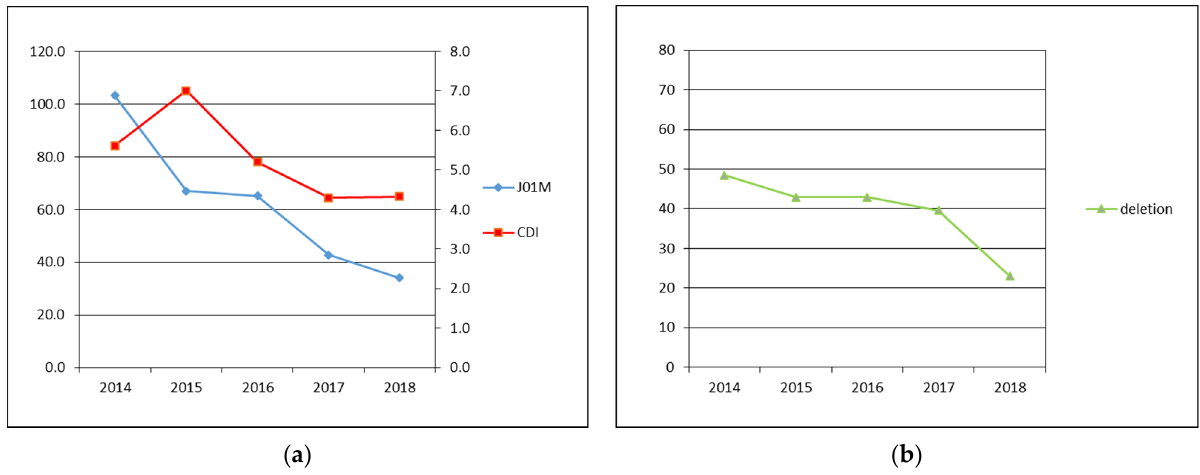
Figure 1. ( a ) Primary axis: J01M—fluoroquinolone antibiotics consumption in DDD per 1000 patient-days, secondary axis: CDI—CDI incidence in cases per 10,000 patient-bed days; ( b ) deletion—prevalence of tcdC gene deletion identified by GeneXpert in %.